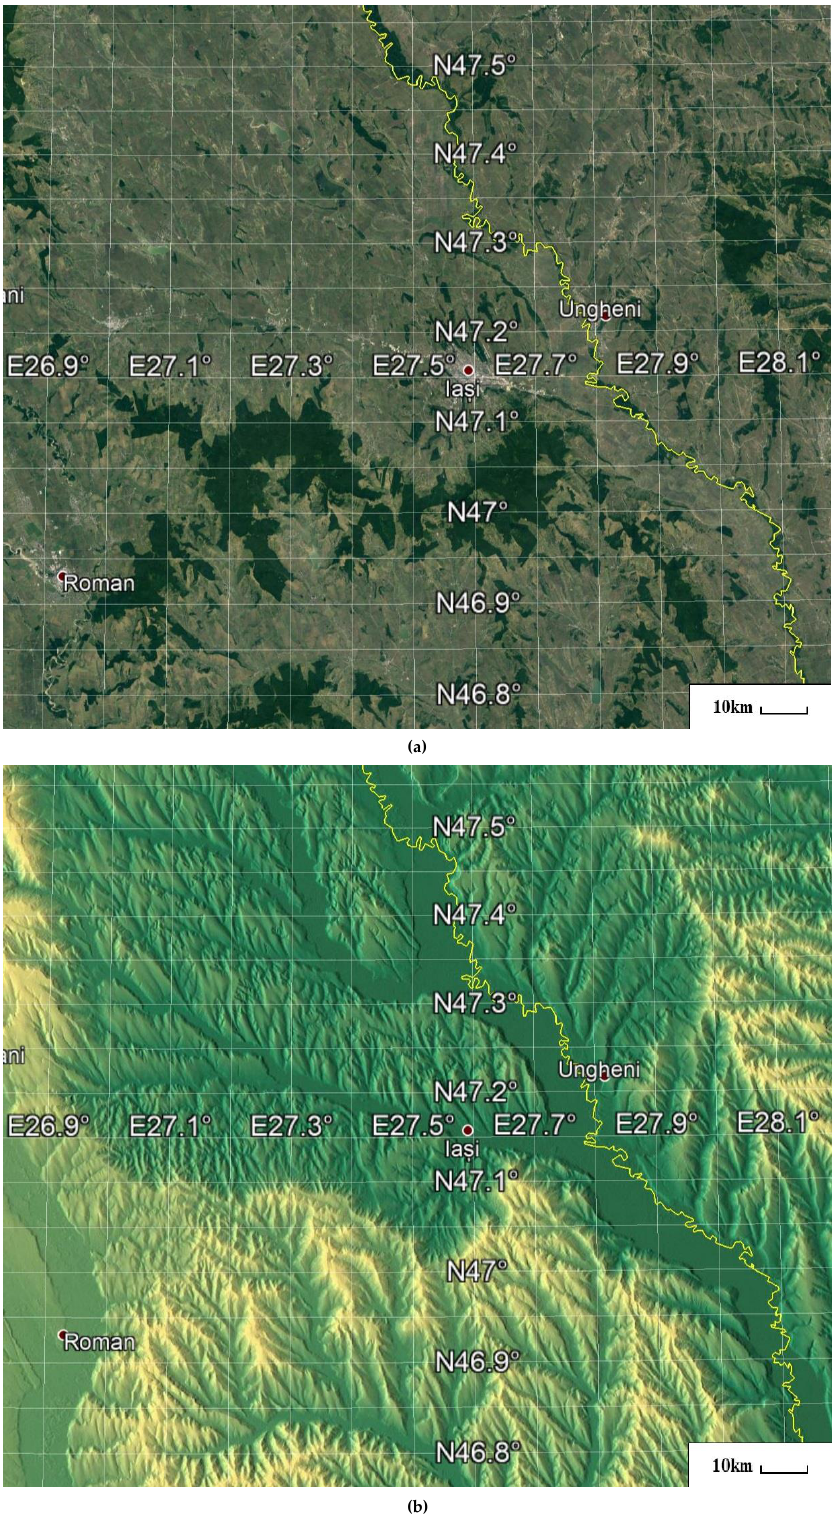
Figure 2 . (a) Satellite map of the 3 rd nest with latitude/longitude grid; border between Romania (right) and Moldova (left) delineated by the Prut river (yellow line); Google Earth. ( b) Relief map of the 3 rd nest with latitude/longitude grid; border between Romania (right) and Moldova (left) delineated by the Prut river (yellow line); altitude colormap: ~5 m above ground-level (AGL) dark green, ≤300 m AGL bright yellow; Google Earth.